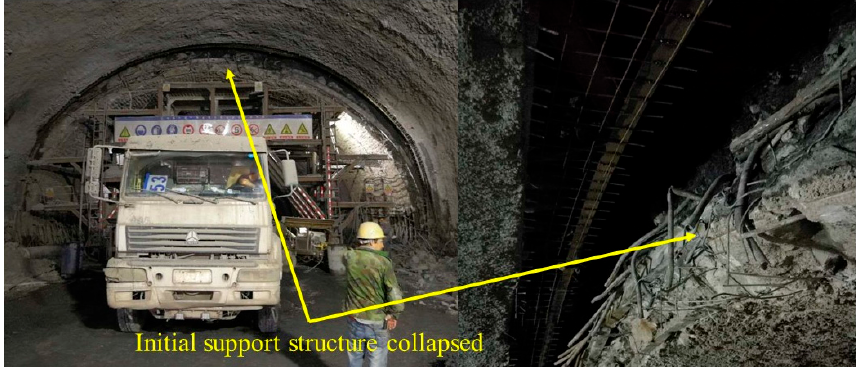
Figure 15. The initial support structure collapsed.